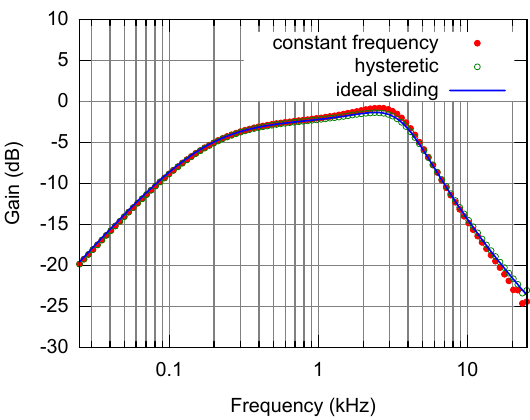
Figure 7. Theoretical and simulated closed-loop output impedance in a boost converter.